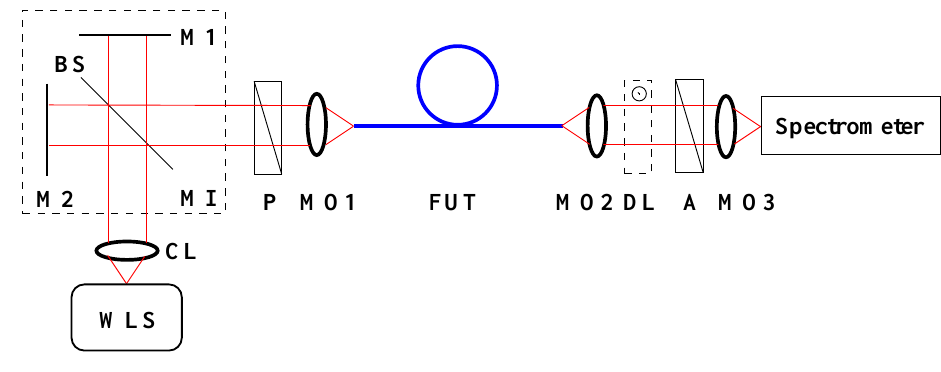
Figure 1. Experimental setup with a Michelson interferometer (MI) for measuring the dispersion of the group modal birefringence in a fiber under test (FUT). The remaining components: a white-light source (WLS), a collimating lens (CL), mirrors 1–2 (M1–2), a beam splitter (BS), a polarizer (P), microscope objectives 1–3 (MO1–3), a delay line (DL) and an analyzer